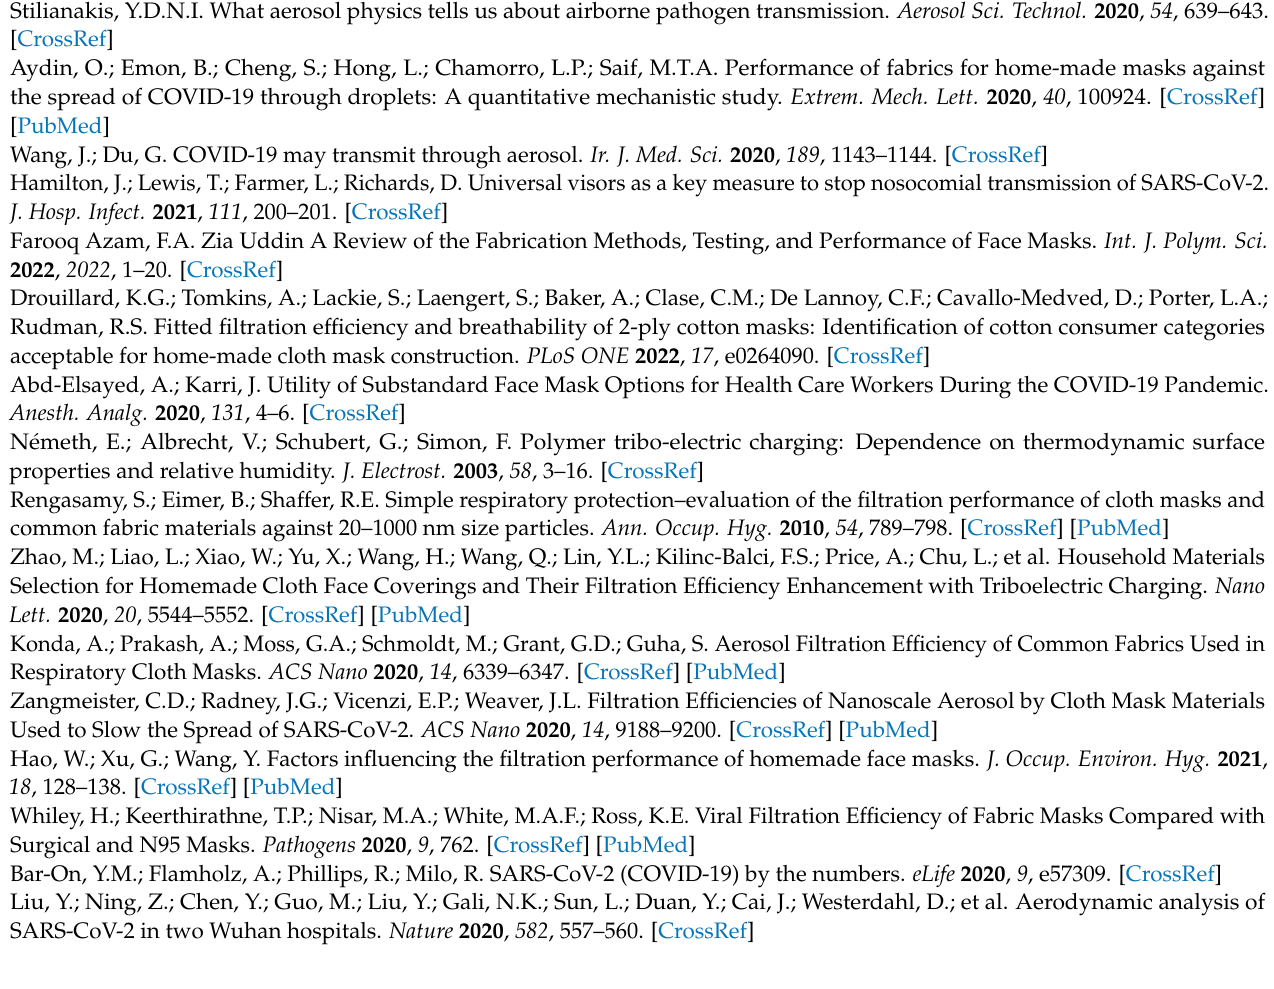
(d–f) the filtration performance graph of the original, trimmed 5 times and trimmed 10 times fabric; Figure S2: (a) The filtration efficiency, (b) pressure drop, (c) quality factor and (d) pore size graph of Cotton 3 and Wool 1 fabrics before and after washing. Table S1: Characteristics and structural properties of the fabric.; Table S2: The basic structure and filtration parameters of different non-woven fabrics. Video S1: The dynamic water contact angle of Cotton3 fabric; Video S2: The dynamic water contact angle of Silk 1